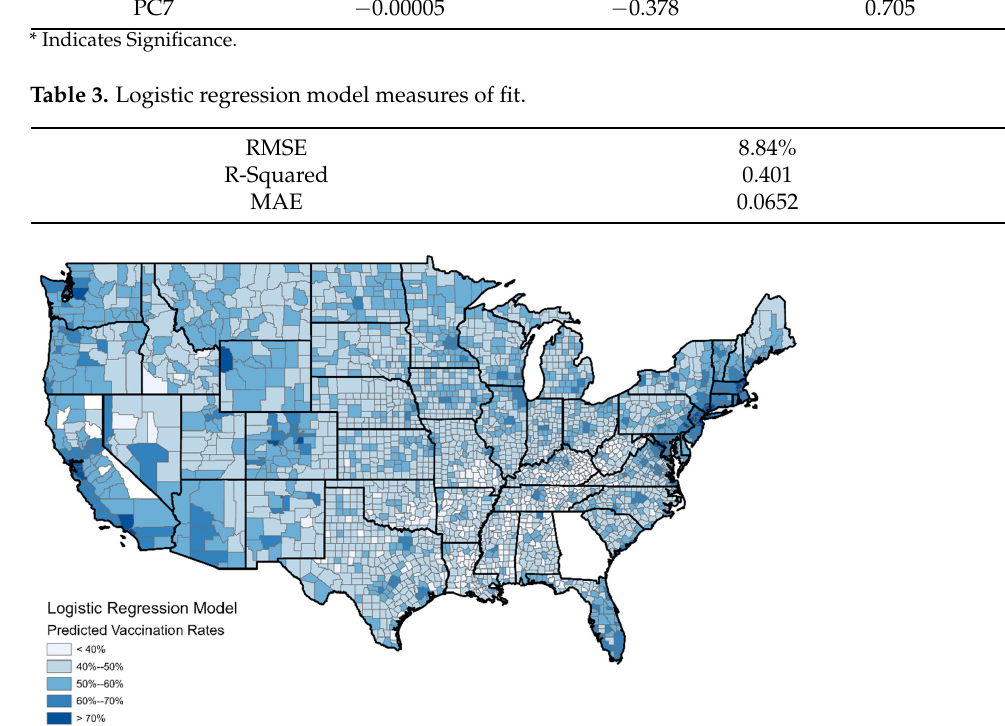
Figure 4. Predicted vaccination rates by county according to logistic regression modeling.